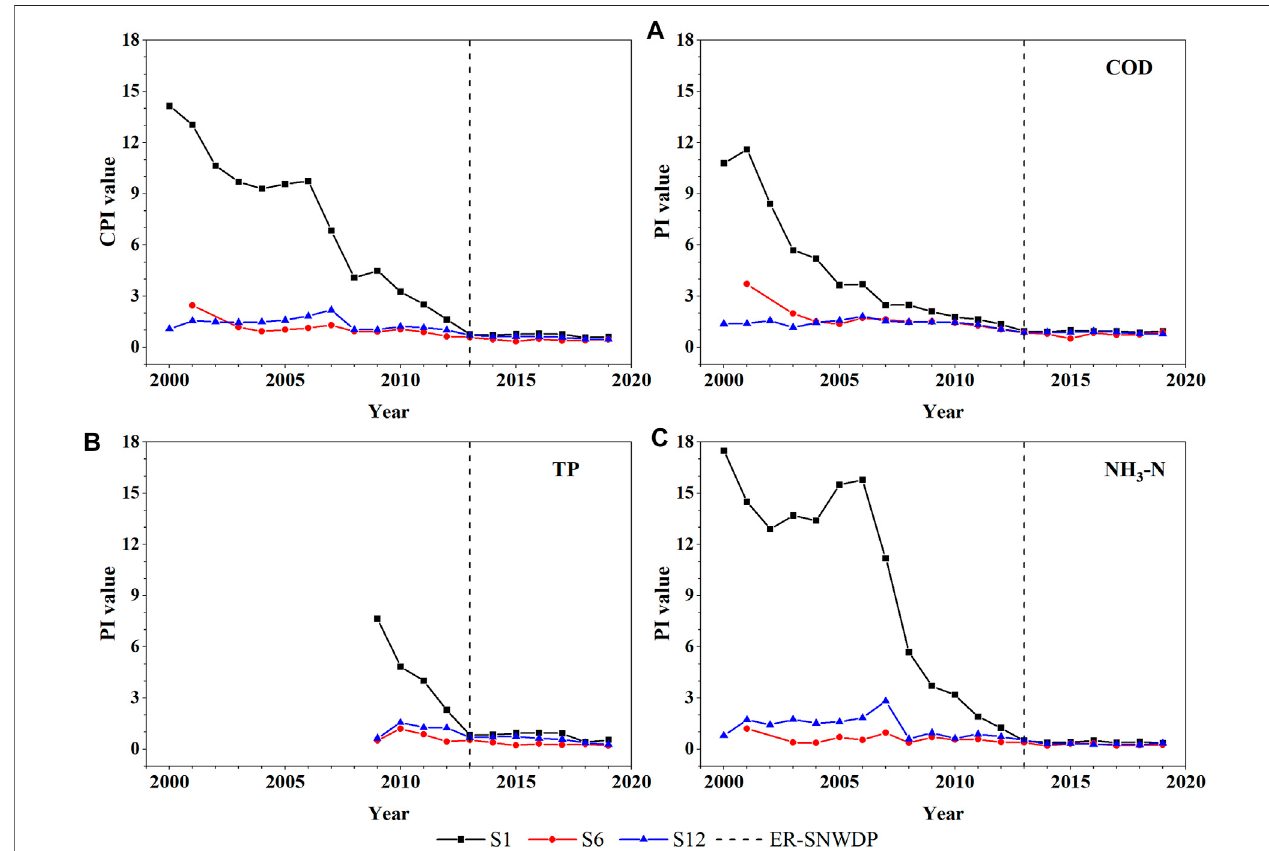
FIGURE 2 | Trends for the CPI and single PIs in the river estuaries (S1: GR, S6: SR, S12: BR, (A) COD, (B) TP, (C) NH 3 -N).